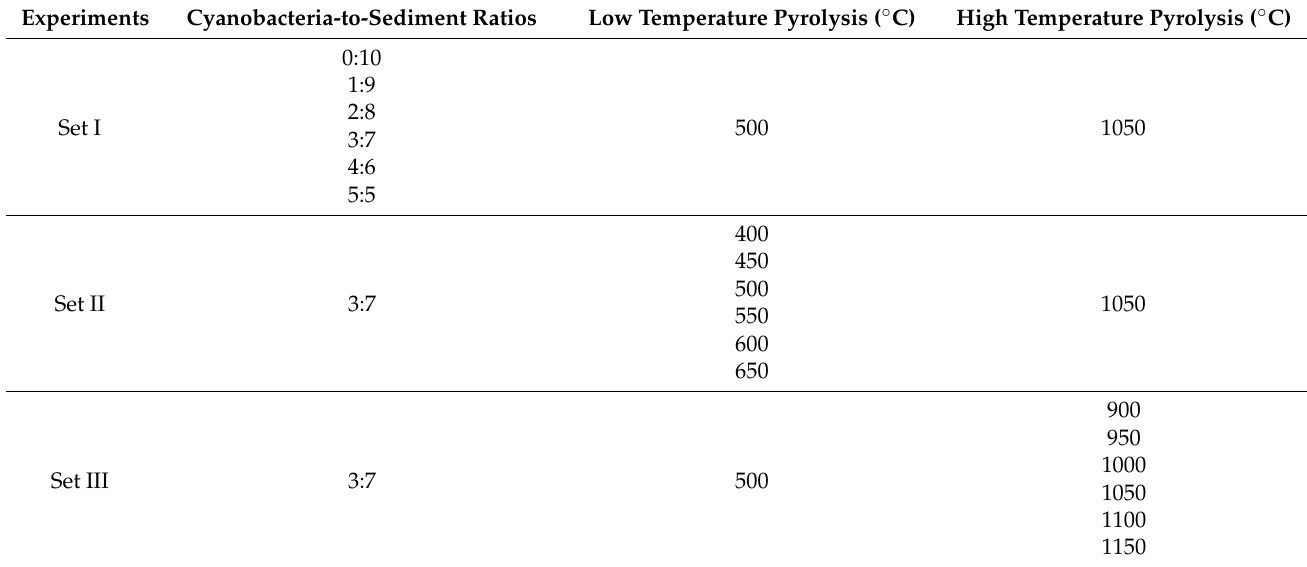
Table 2. Set table of experimental protocol for ceramsite production.